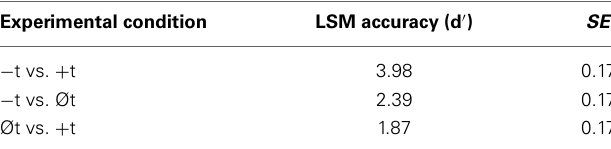
Table 3 | Least Square Means (LSM) of Accuracy for different item categories.